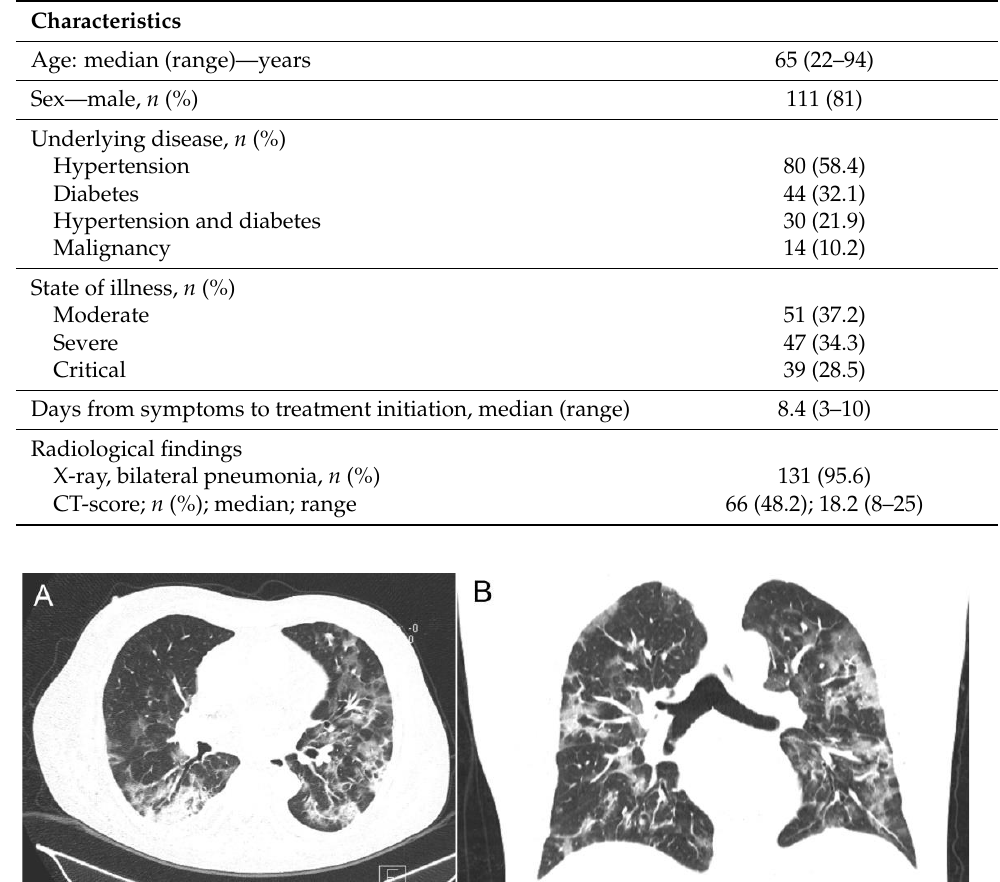
Table 1. Demographic and clinical characteristics of 137 hospitalized patients treated with remdesivir.